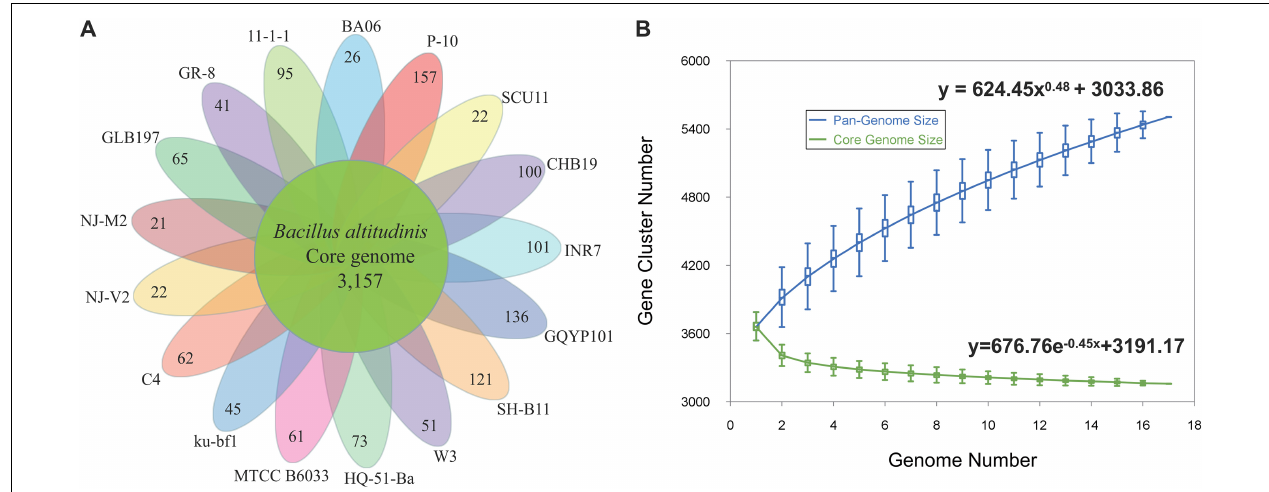
FIGURE 3 | The pan-genomes of 17 B. altitudinis strains. (A) The number of unique CDS for each strain of the B. altitudinis pan-genome. The inner circle shows the core genomes shared between all strains. The specific genes for each strain are indicated in each of the outer circles. (B) Curves for B. altitudinis pan-genomes and core genomes. The blue dots denote the B. altitudinis pan-genome size for each genome comparison whereas the green dots indicate the B. altitudinis core genome size for each genome comparison. The median values were connected to represent the relationship between number of genomes and gene families.